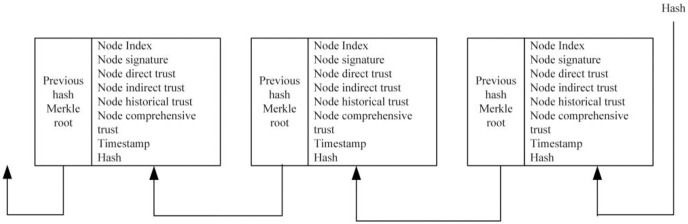
Node trust data block structure.